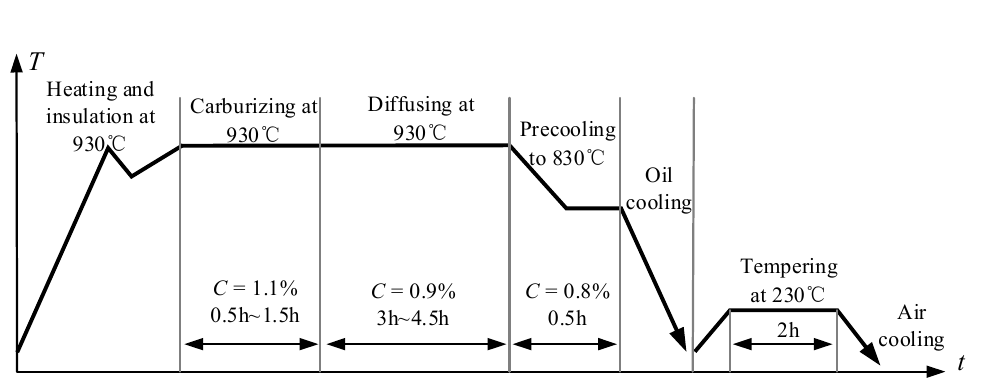
Figure 5. The curve of the thermal treatment process. Through the motion and force analysis of the cycloidal gear and cylindrical roller bearing (Figure 6), the resultant force acting on the cylindrical roller bearing is obtained. The cylindrical roller bearing bears the force from the cycloidal gear and the crankshaft. 𝐹 j 1 , 𝐹 j 2 , and 𝐹 j 3 are the components of force, F , which acts on the cycloidal gear via the cylindrical roller bearing (as shown in Figure 6a). F can also be decomposed into the nor ‐ mal force, 𝐹 r , and tangential force, 𝐹 t (as shown in Figure 6b).